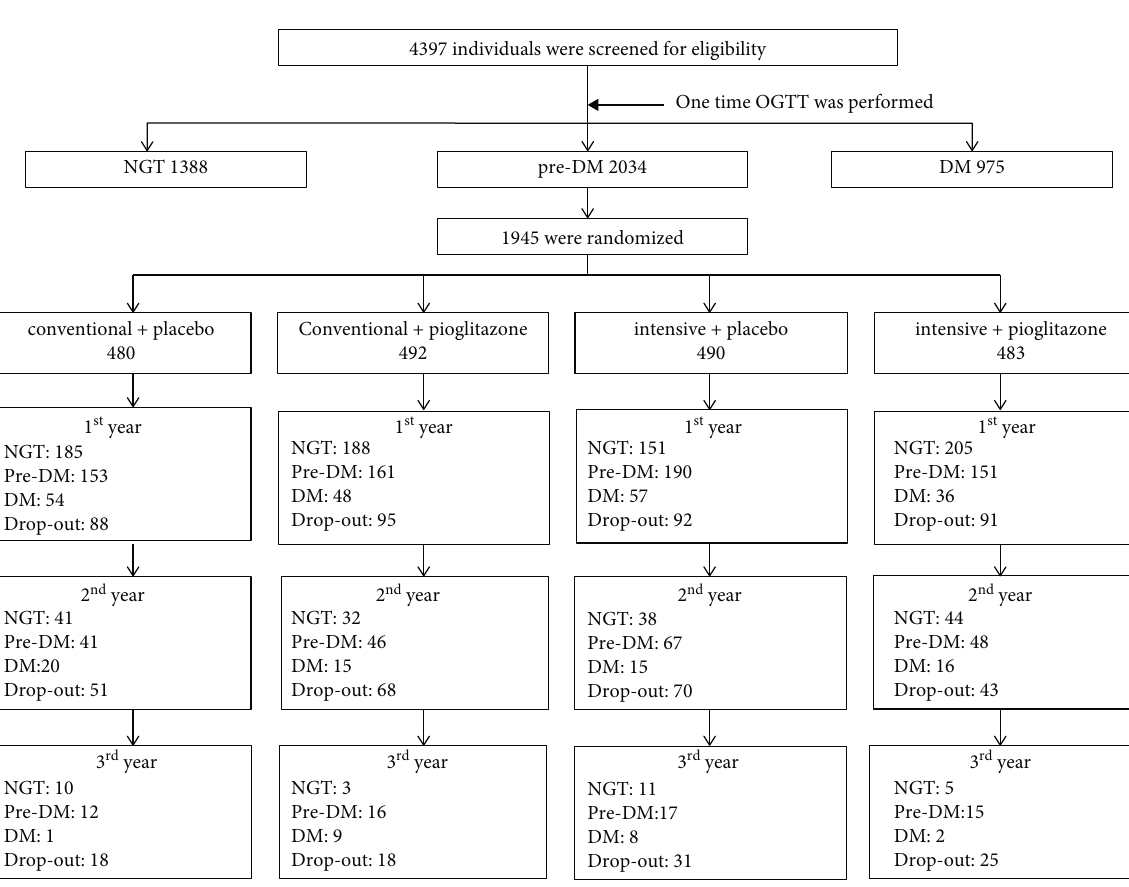
Figure 1: Participant fl